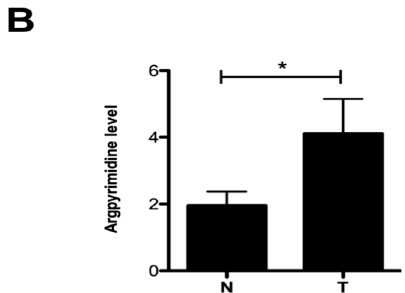
Figure 1. Argpyrimidine adducts are highly accumulated in colorectal cancer tissues when compared to matched non-cancer tissue. ( A ) Argpyrimidine adducts have been evaluated in 12 CRC tissues (T) and in their non-tumor counterpart (N) by Western blot analysis. HSC70 and Ponceau Red staining are both shown as loading control. The quantification of all visible bands corresponding to argpyrimidine adducts has been performed using ImageJ software (NIH Image, http://rsb.info.nih.gov/ij/, 1.42p, RRID:SCR_003070). Tumor to normal tissue (T/N) ratio of argpyrimidine adducts is shown for each patient. The most intense band of the Ponceau Red staining (boxed in red) has been used for the normalization; ( B ) Quantification of panel (A) data demonstrates a significant overall increase of MG-adducts in tumor tissues compared to normal counterpart. Bars represent the mean ± SEM of 12 patients analyzed. Statistical analysis has been performed using one way Anova, Mann–Whitney test and * p < 0.05.